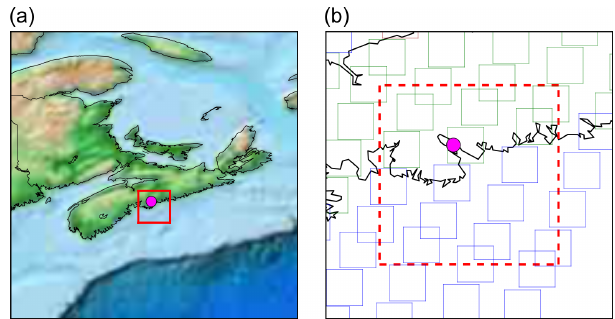
Figure 1. (a) Map of Nova Scotia and the surrounding region in Atlantic Canada. Lighter colours on land indicate higher elevation. The pink dot shows the location of Halifax, the coastal city that we focus on in this study (see Sect. 2.1.3), and the red box shows the MOPITT L3 1 ◦ × 1 ◦ grid box containing Halifax. (b) Map zoomed to the MOPITT L3 grid box containing Halifax (red dashed box), with the approximate location of individual L2 retrieval footprints shown (blue boxes represent the L2 surface index of water; green boxes represent the L2 surface index of land). L2 retrieval footprints with a midpoint that falls within the boundaries of the L3 grid box will be averaged together to create the L3 data, according to certain rules – see Sect. 2.1.2 for full